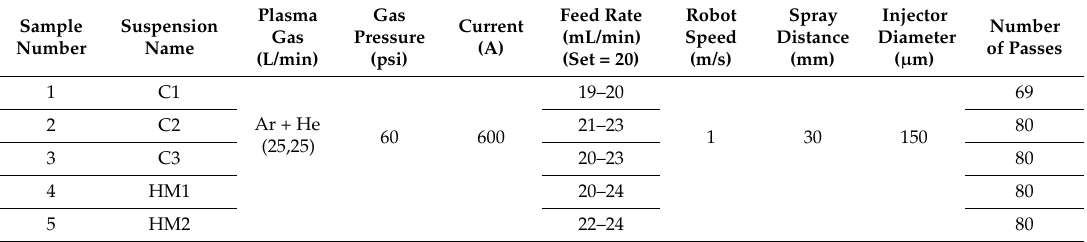
Table 2. Spray conditions using 3MB torch with radial injection and no prior suspension atomization.